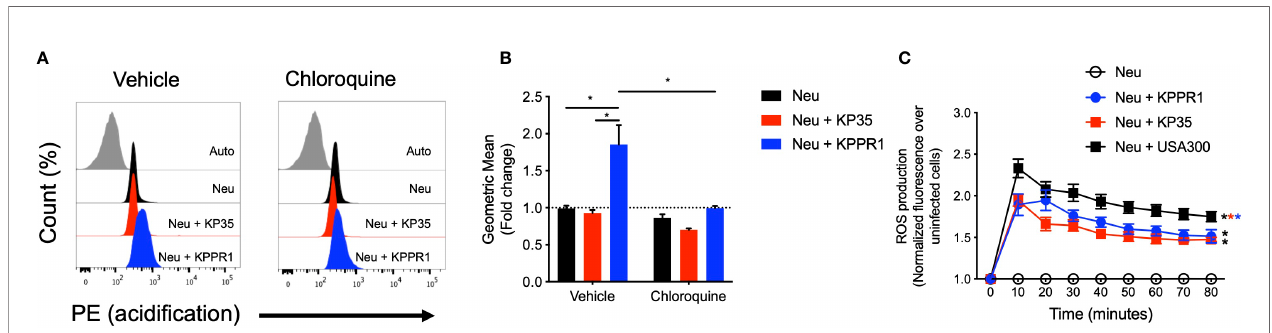
FIGURE 4 | KP35 prevents neutrophil phagosome acidi fi cation but induces equivalent levels of ROS compared to KPPR1. (A) Isolated neutrophils were split in two groups and treated with chloroquine or vehicle. Then each group was infected with KPPR1 and KP35 and after 30 min (B) phagosome acidi fi cation was measured by fl ow cytometry. (C) ROS production by neutrophils was measured every 10 min for 80 min. *P < 0.05, each group was compared using a two-way ANOVA test followed by a Tukey ’ s test for multiple comparisons.